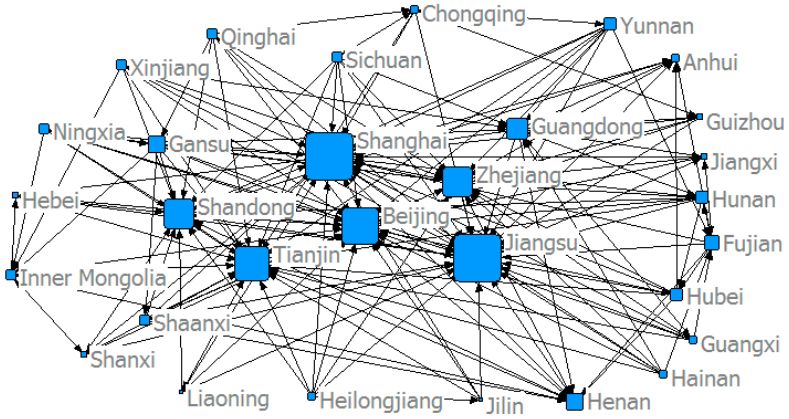
Figure 5. The structure of the ANTCE in 2007.